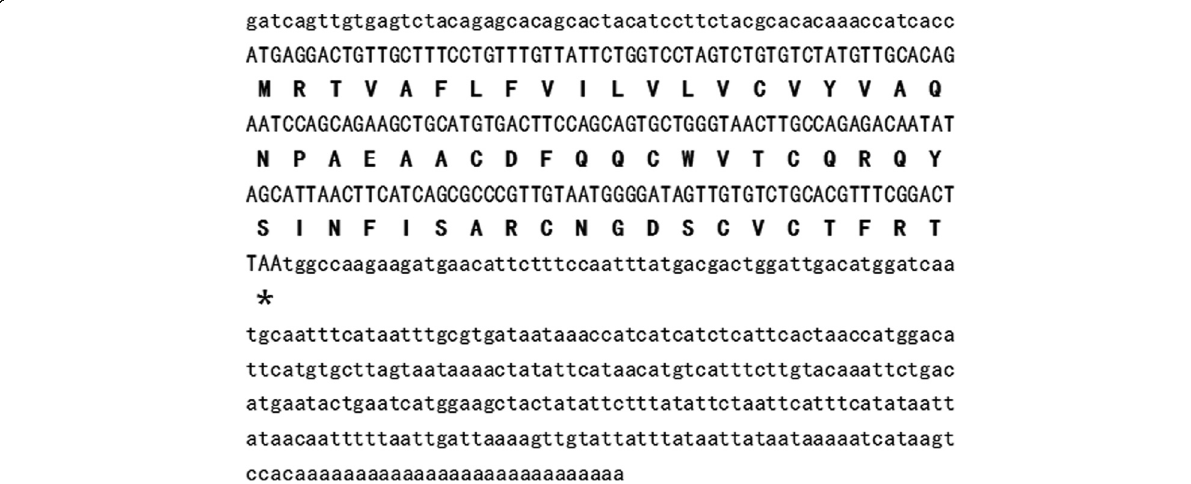
Fig. 5 Amino acid sequences of Es-termicin and its cDNA sequence from cockroach E. sinensis . 5 ’ and 3 ’ uncoding regions are shown in lowercase letters. The stop codon is indicated by asterisk. The signal peptide is shown with underlines. Mature protein sequence is